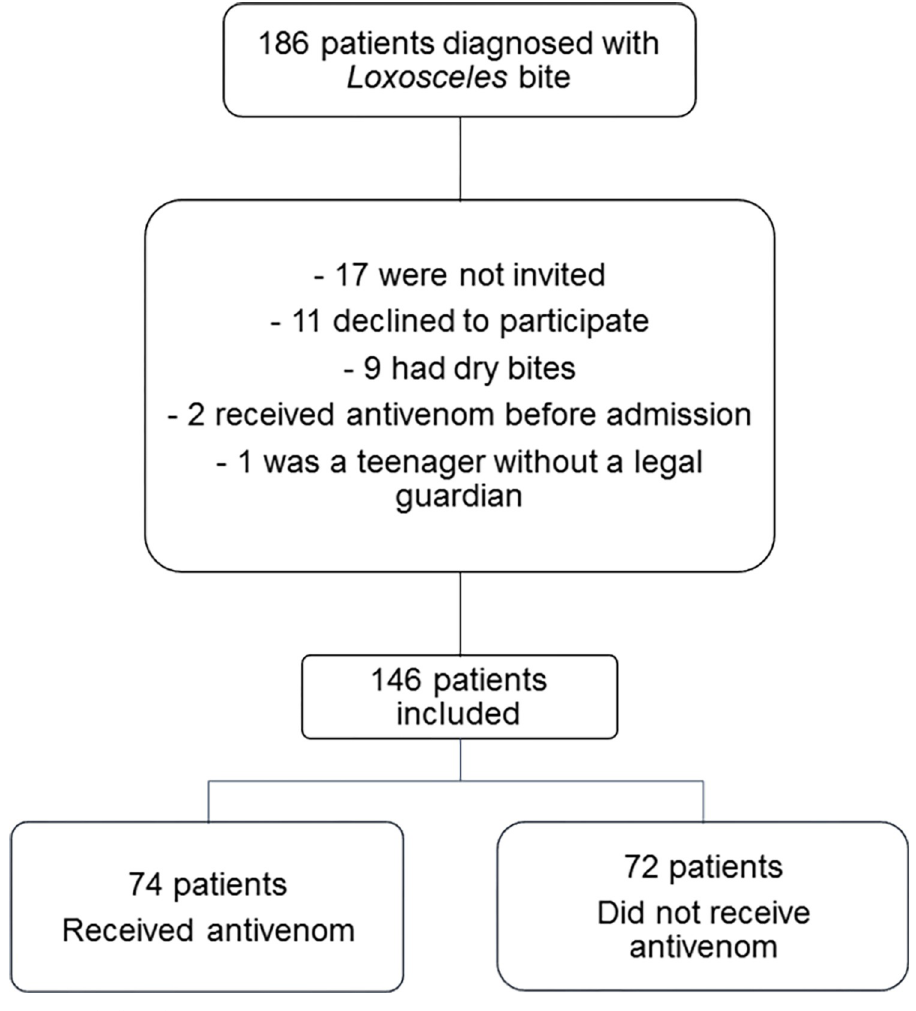
Fig 1. Study flow